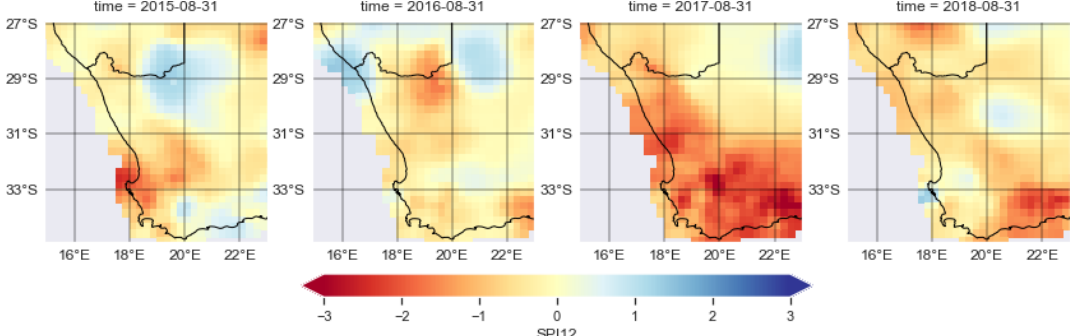
Figure 5. Twelve-month SPI for the periods ending in August of the years indicated in GPCC data.